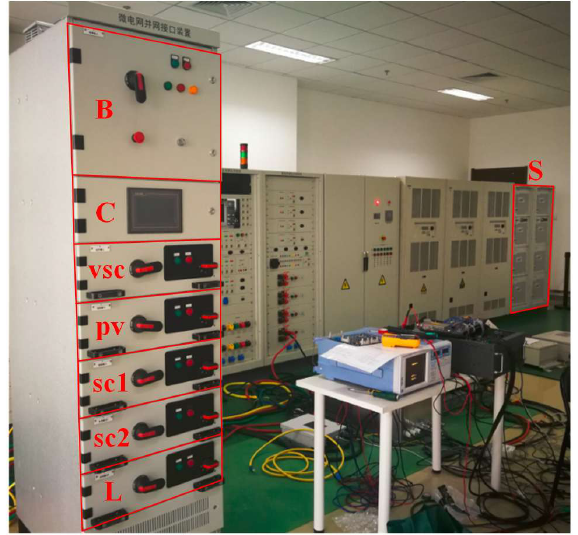
Figure 14. DC microgrid experimental platform.